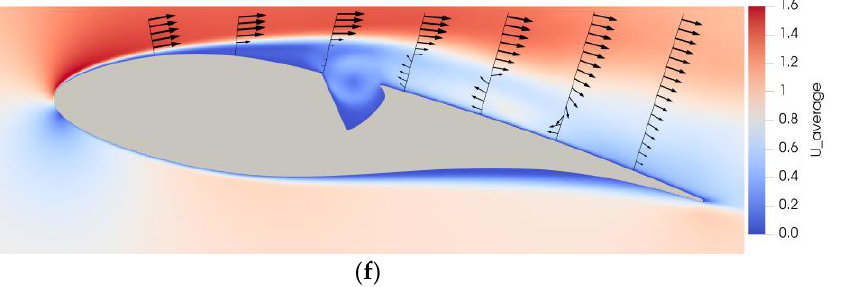
Figure 11. Time-averaged flow visualization for α = 9°: ( a ) Streamlines of standard Risø airfoil; ( b ) streamlines of an airfoil with cavity A; ( c ) vorticity contours standard Risø airfoil; ( d ) vorticity contours airfoil with cavity A; ( e ) velocity distribution for standard Risø airfoil; ( f ) velocity distribution for an airfoil with cavity A.